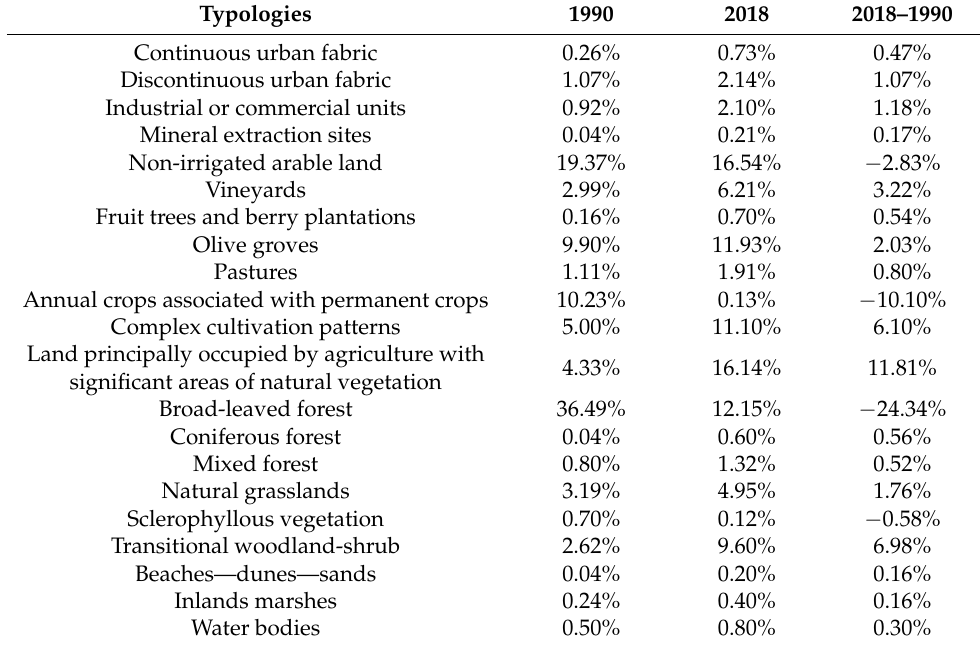
Table 1. Percentages of land use between 1990 and 2018 calculated in the area of the Lucanian Ofanto basin.